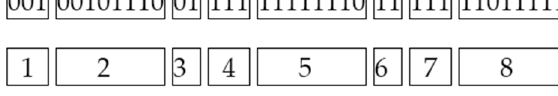
Figure 2. Example of a chromosome.